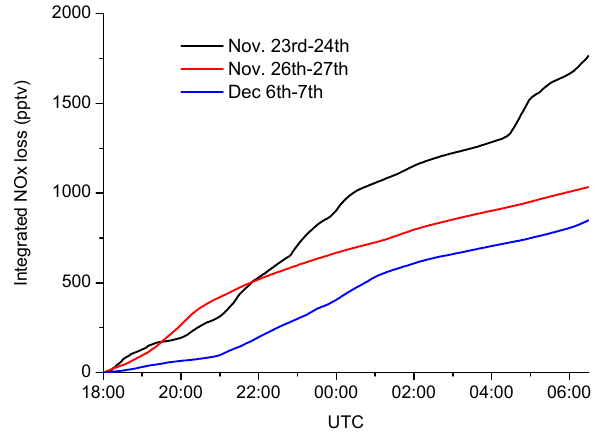
Fig. 13. Relationship between NO 3 lifetimes, τ ss (NO 3 ) and the mixing ratios of NO 2 , SO 2 and aerosol surface area (ASA) during the entire